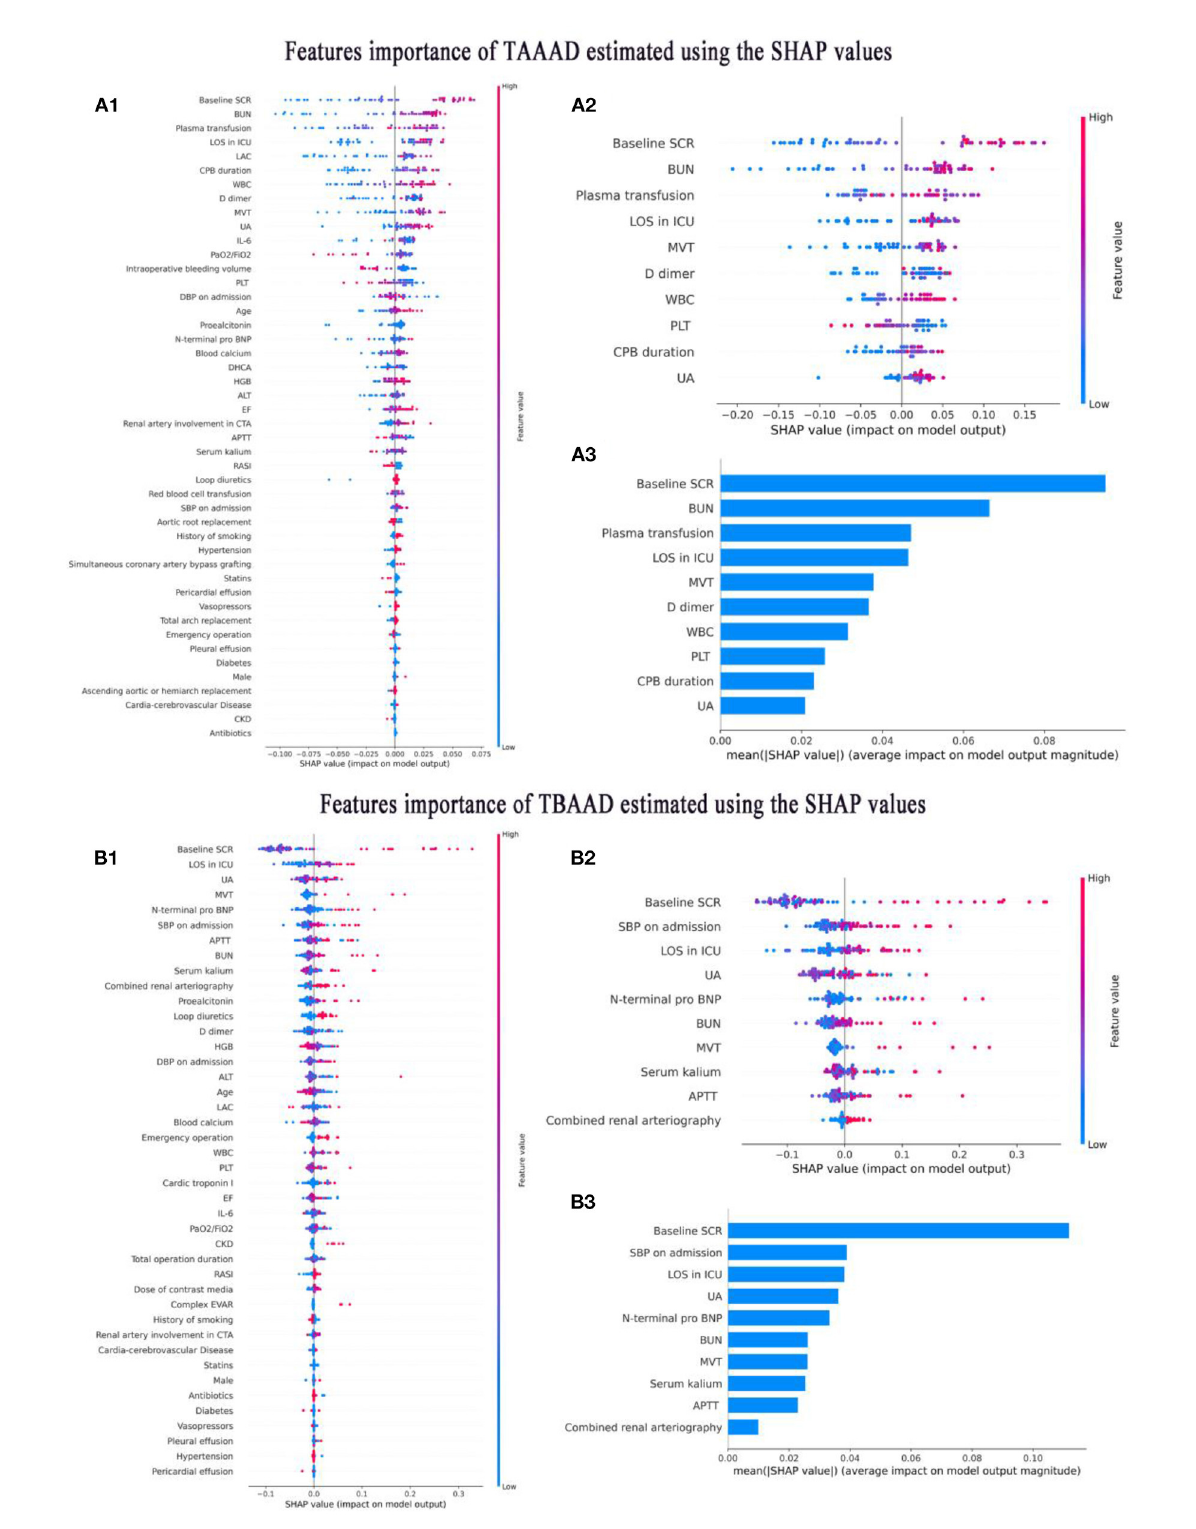
FIGURE6 Interpretation of variable importance using SHAP values. SHAP assigns points to each feature of the patient in the graph, with features decreasing in importance from high to low, and colors representing the magnitude of the feature value (high in red, low in blue); the X- axis is used to measure the impact of the feature on AKI (positive on the right, negative on the left; the higher the value, the stronger the impact). (A1–A3) Shows the features importance of TAAAD-AKI. (B1–B3) Shows the features importance of